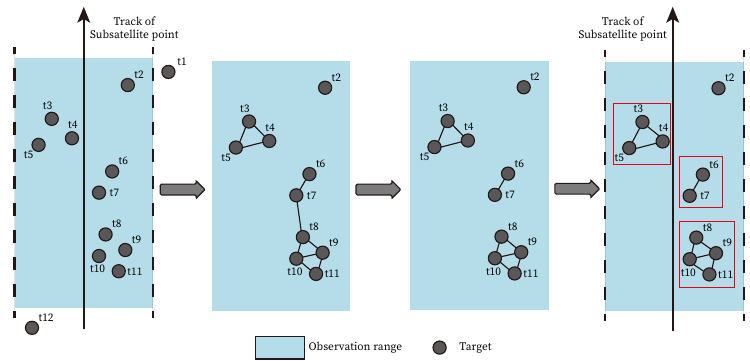
Figure 2. Illustration of clique partition for clustering graph.